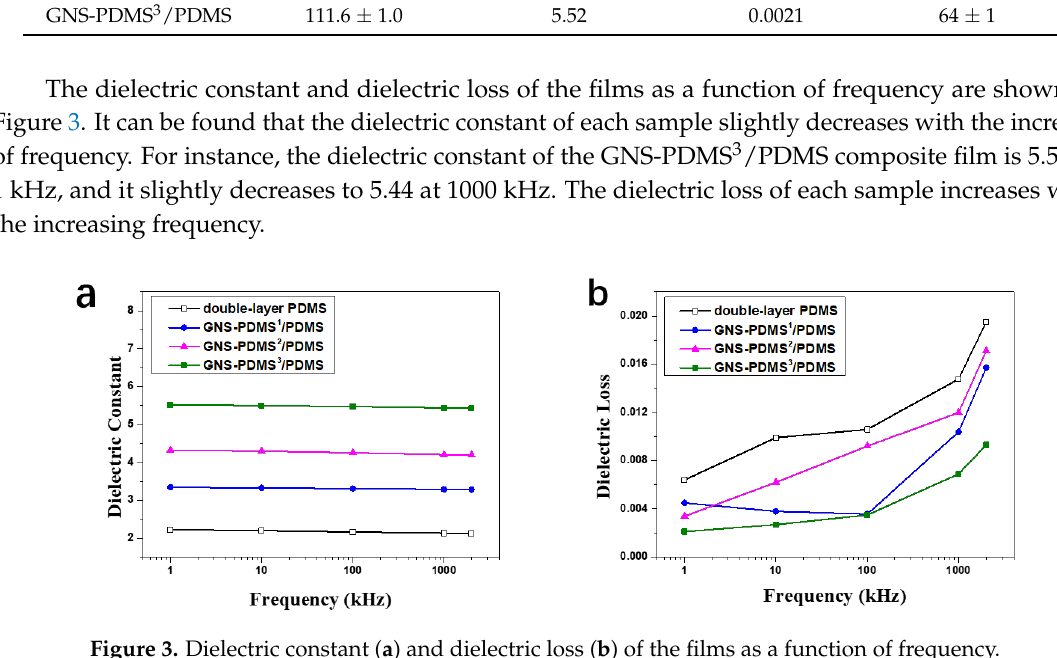
Figure 3. Dielectric constant ( a ) and dielectric loss ( b ) of the films as a function of frequency.